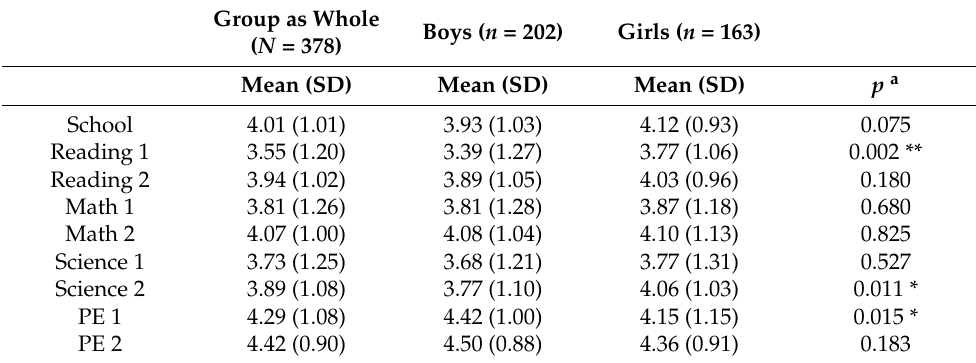
Table 3. Mean and standard deviations group as